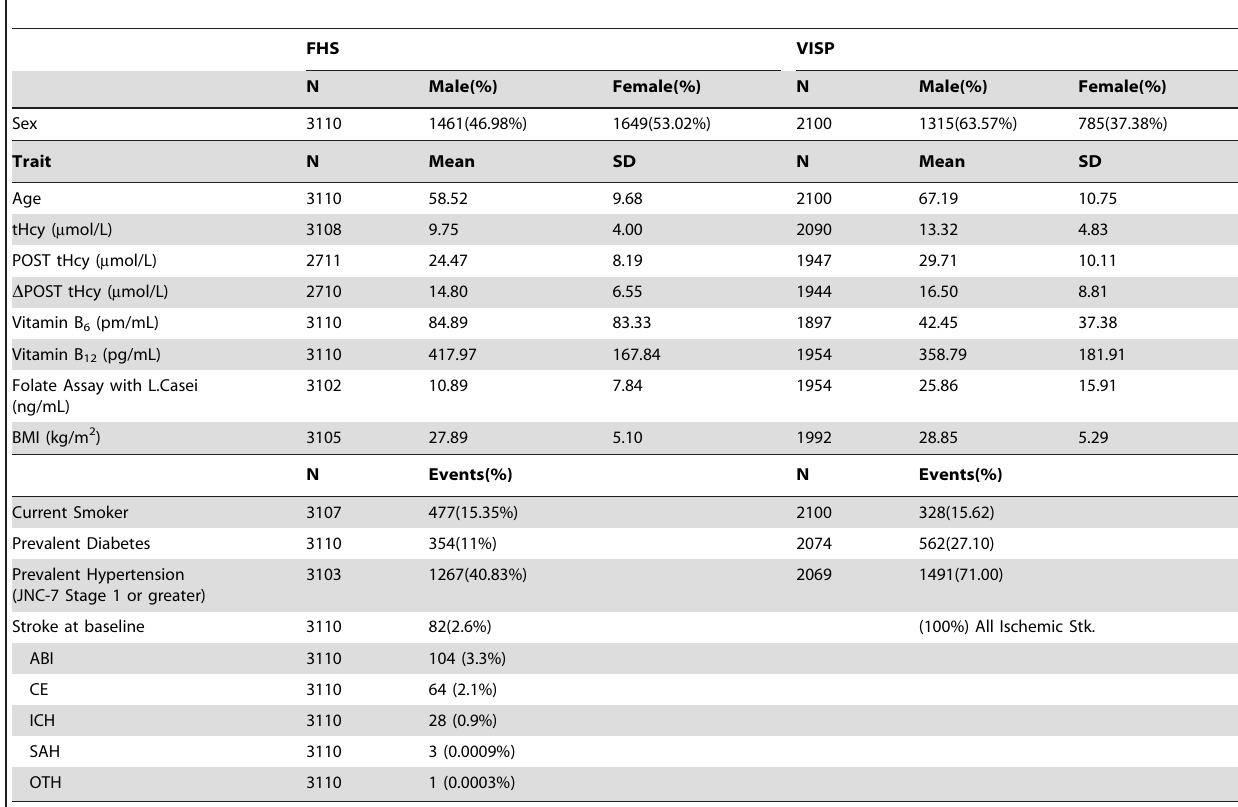
Table 1. Summary statistics for Framingham Heart Study (FHS) and Vitamin Intervention for Stroke Prevention (VISP)